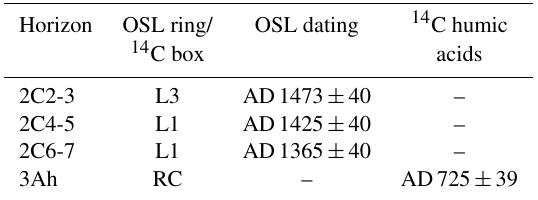
Table 2. Absolute dating of the Bedafse Bergen profile (Fig. 10,